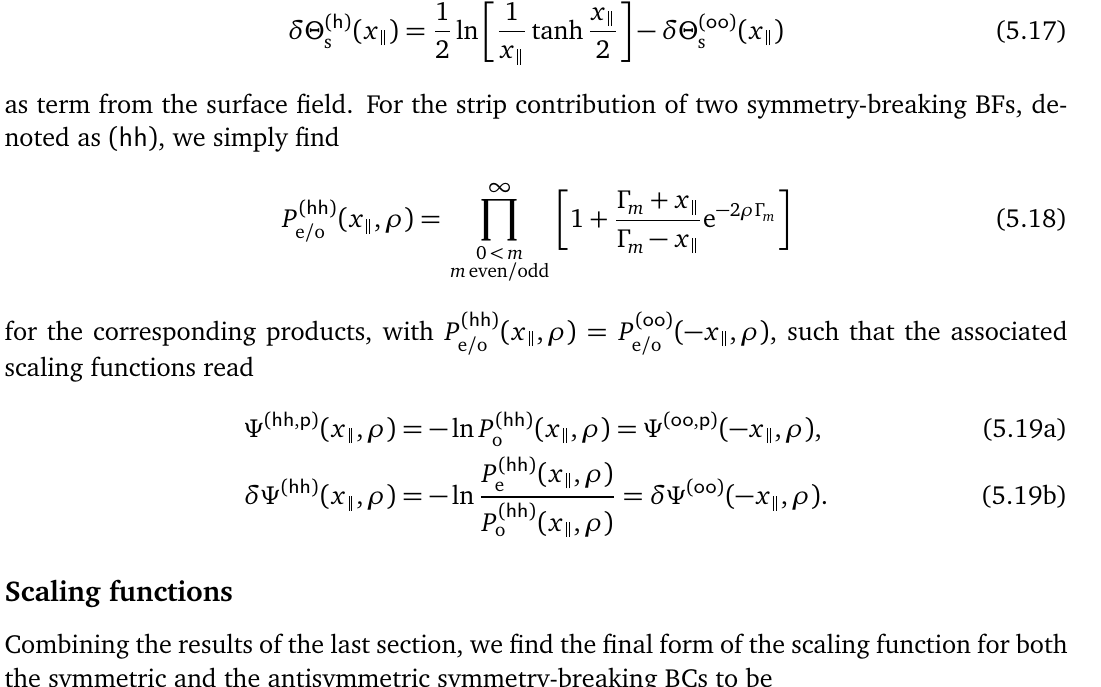
Figure 18: Scaling function Θ aspect ratios ρ ≤ 1. For ρ < 1, the scaling function converges extremely fast toward the thin film limit Θ